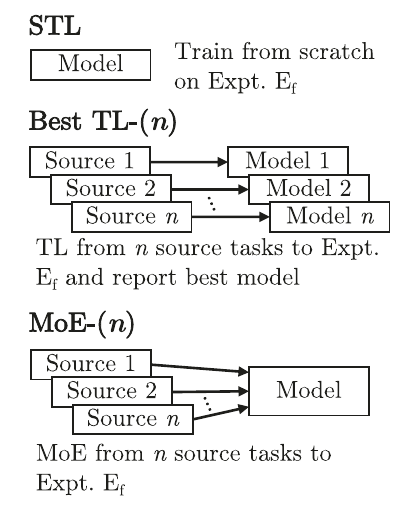
Fig. 2 Visualization of STL, Best TL-( n ), and MoE-( n ). The experimental formation energy task is used for